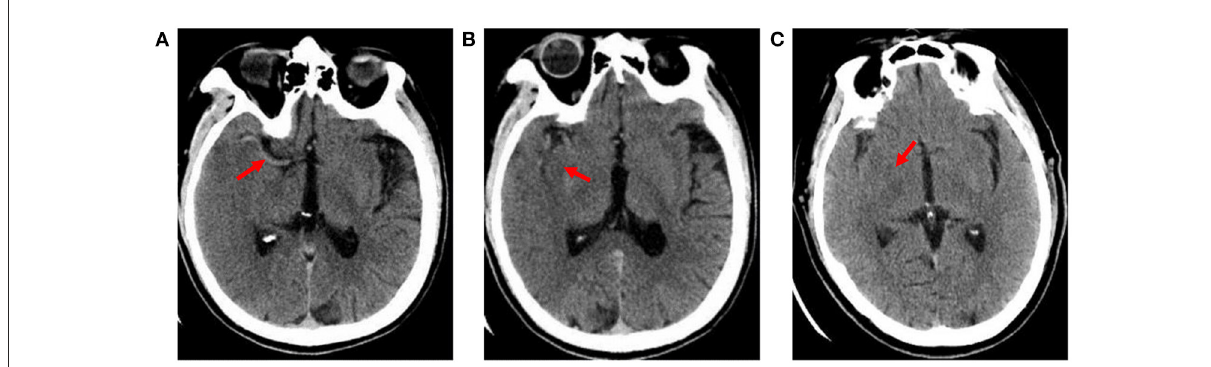
FIGURE1 Early imaging signs on CT. (A) hyperdense middle cerebral artery sign: the M1 segment of the right middle cerebral artery shows high density (X-ray uptake value of 64 HU); (B) insular ribbon sign: the gray-white matter interface of the right insular zone disappears, and the cerebral sulcus becomes shallow; (C) obscuration of the lentiform nucleus: the right lentiform nucleus structure is blurred, and the density is reduced (the CT average value is 27.4 HU; the CT average value of the same area on the healthy side is 34 HU).